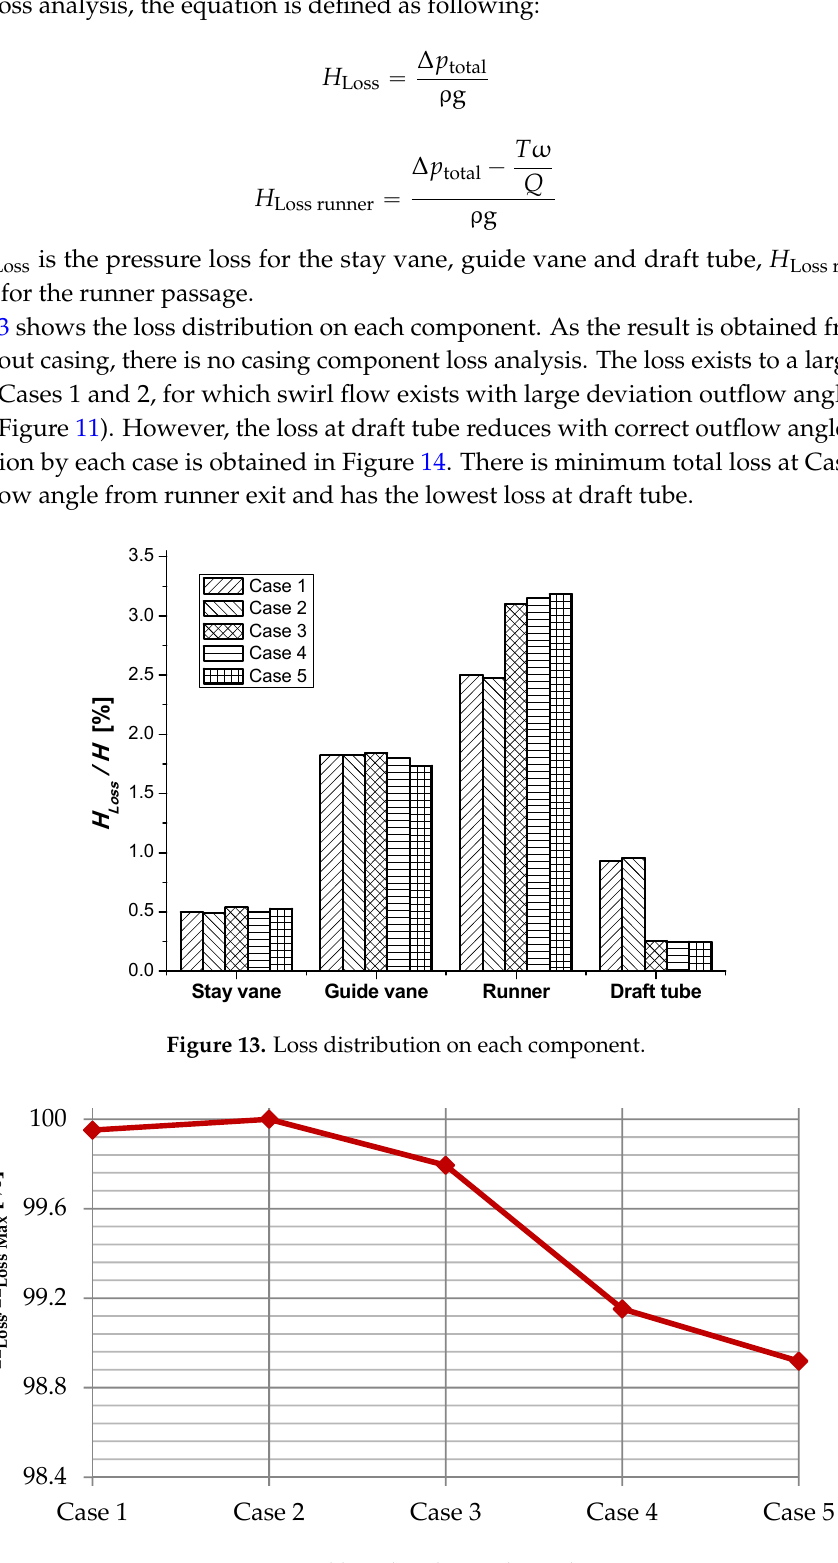
Figure 14. Total loss distribution by each case.